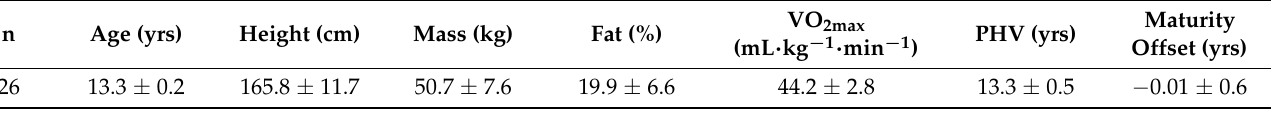
Maturity Offset (yrs)